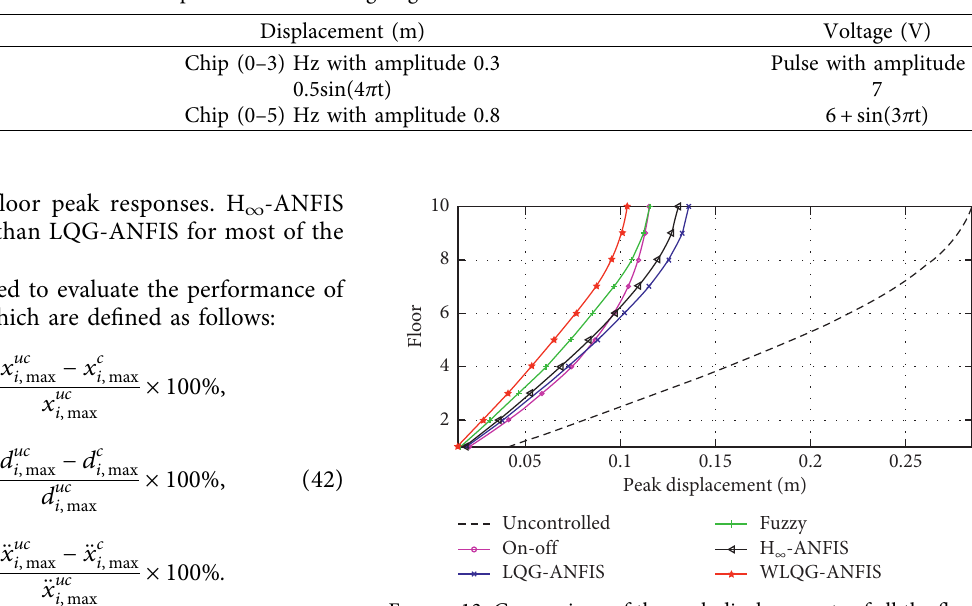
Table 5: Displacement and voltage signals for validation datasets.